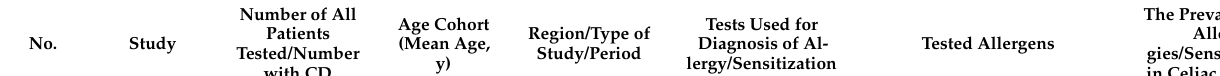
Table 2. Summary of original studies assessing the coexistence of allergy/sensitization and